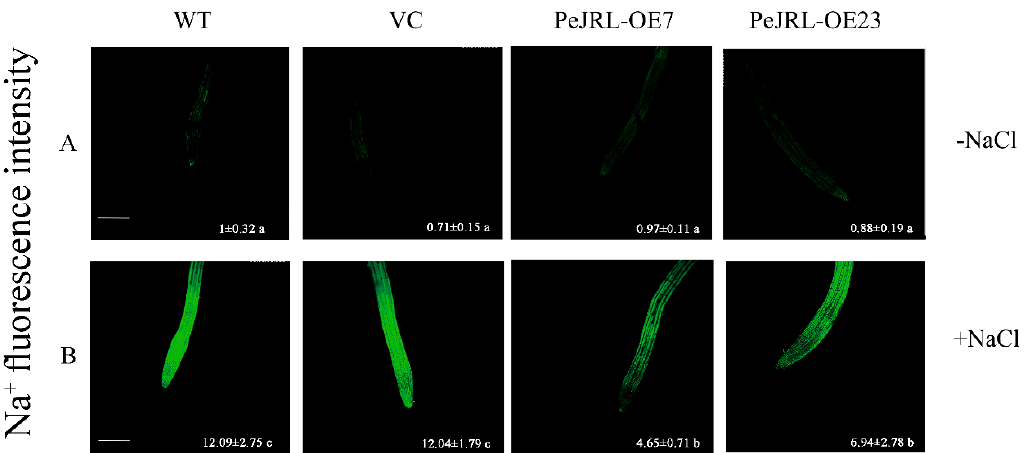
Figure 6. Na + fluorescence intensity in root cells of wild-type (WT) Arabidopsis, vector control (VC), and PeJRL -transgenic lines (OE7 and OE23) under NaCl stress. Seven-day-old seedlings were exposed to 1/2 MS liquid medium supplemented with or without 125 mM NaCl for 12 h, then incubated with CoroNa-Green AM to detect Na + concentrations. Green fluorescence in root cells was measured at the apical region of roots under a Leica confocal microscope. Representative confocal images show Na + fluorescence intensity in control ( − NaCl) ( A ) and salt-stressed roots (+NaCl) ( B ). Values ( ± SE) show the mean fluorescence intensity of CoroNa-Green AM. Each value corresponds to the mean of 6–9 independent plants. Values labelled with different letters (a–c) donate significant differences at p < 0.05. Scale bar = 250 μ m.